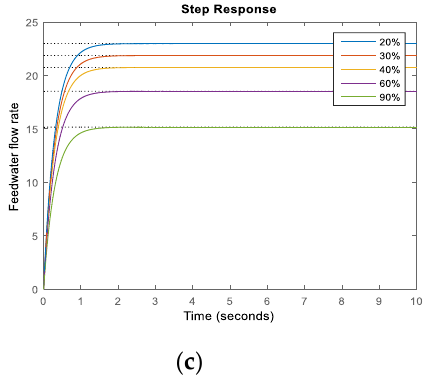
Figure 12. Reponses of identification model to ( a ) 1 lbm/s step in feedwater flow rate, ( b ) 1 lbm/s step in steam flow rate, and ( c ) 1% step in feedwater valve.